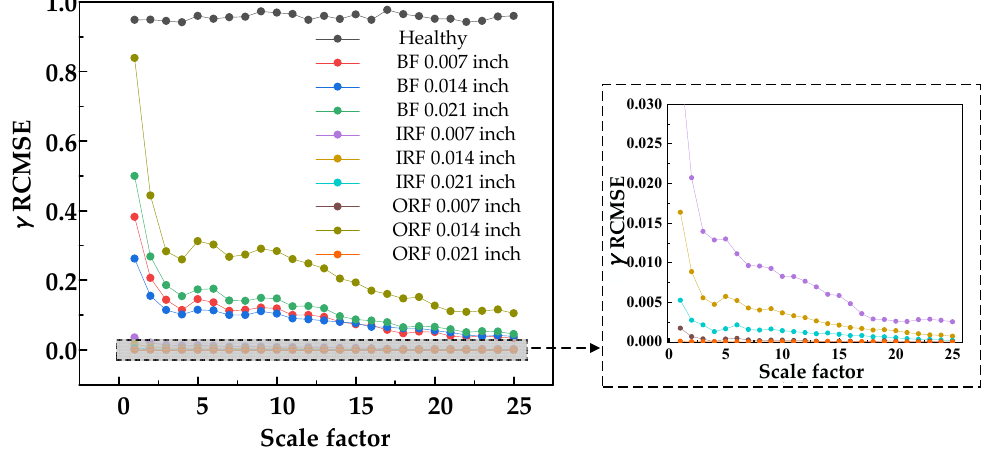
Figure 13. γ RCMSE entropy values of 25 scale factors under different damage degrees.